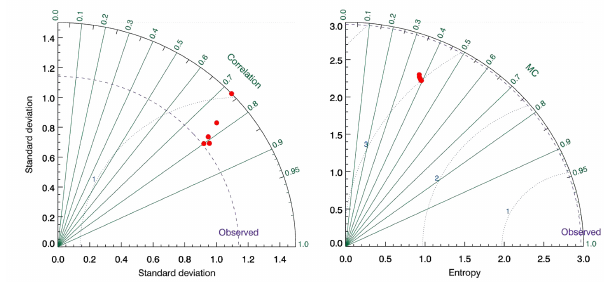
Figure 3. The left panel shows a Taylor diagram obtained for the GPS IWV time series collected at Lindenberg, and the same time series but adding to the IWV probability density function 5, 10, 20, 30, and 40 outliers respectively. The correlation has been calculated with respect to an underlying Gaussian distribution fitted to 637 the data; in the right panel, a modified Taylor diagram is obtained by replacing the standard deviation with the entropy and ρ with MC.